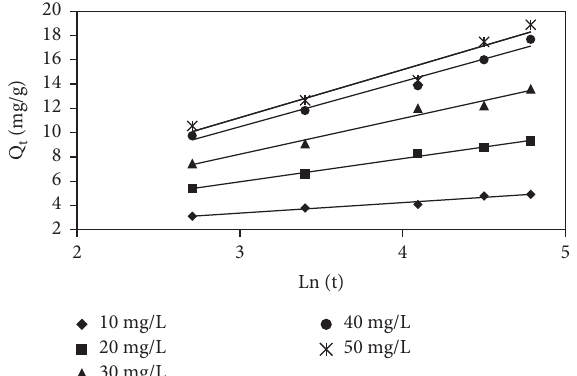
Figure 13: Linearity of Elovich